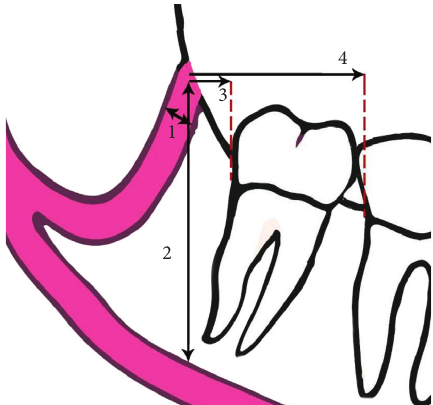
Figure 2: (1) The diameter of the RC at 3mm below the center of its foramen. (2) The vertical distance between the retromolar foramen and the superior border of the MC. (3, 4) The distance between the mesial point of the retromolar foramen and the closest point of the third and second molars at the cementoenamel junction, respectively.